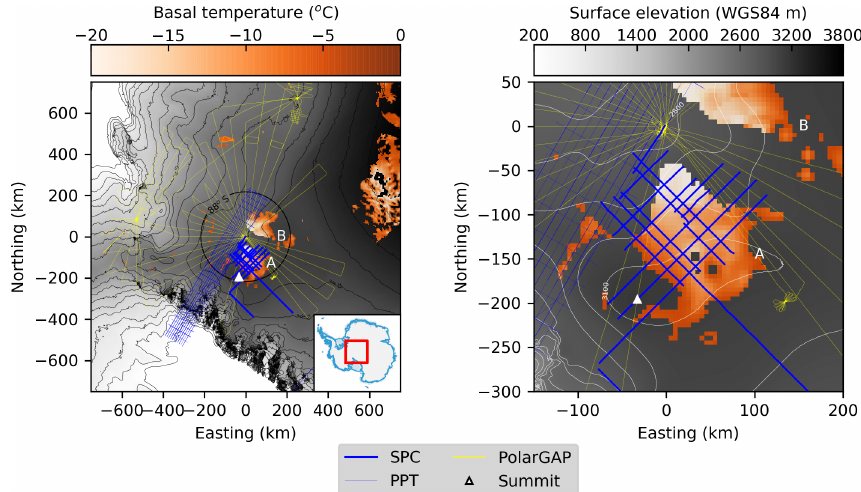
Figure 1. South Pole and Titan Dome region. For both panels, flight lines from the South Pole corridor (SPC) survey and previously published observations of Pensacola–Pole Transect (PPT; Carter et al., 2007) and PolarGAP (Jordan et al., 2018) surveys are also plotted. The orange shading shows candidate regions of increased paleoclimate ice core potential plotted as basal temperature (Van Liefferinge and Pattyn, 2013). Each color bar applies to both panels. The two coring candidate regions discussed in this paper are labeled A and B. The location of Titan Dome summit, as determined from the SPC survey, is the white triangle. The background shading and contours are from the Bamber et al. (2009) surface elevation DEM. The coordinate system used is polar stereographic